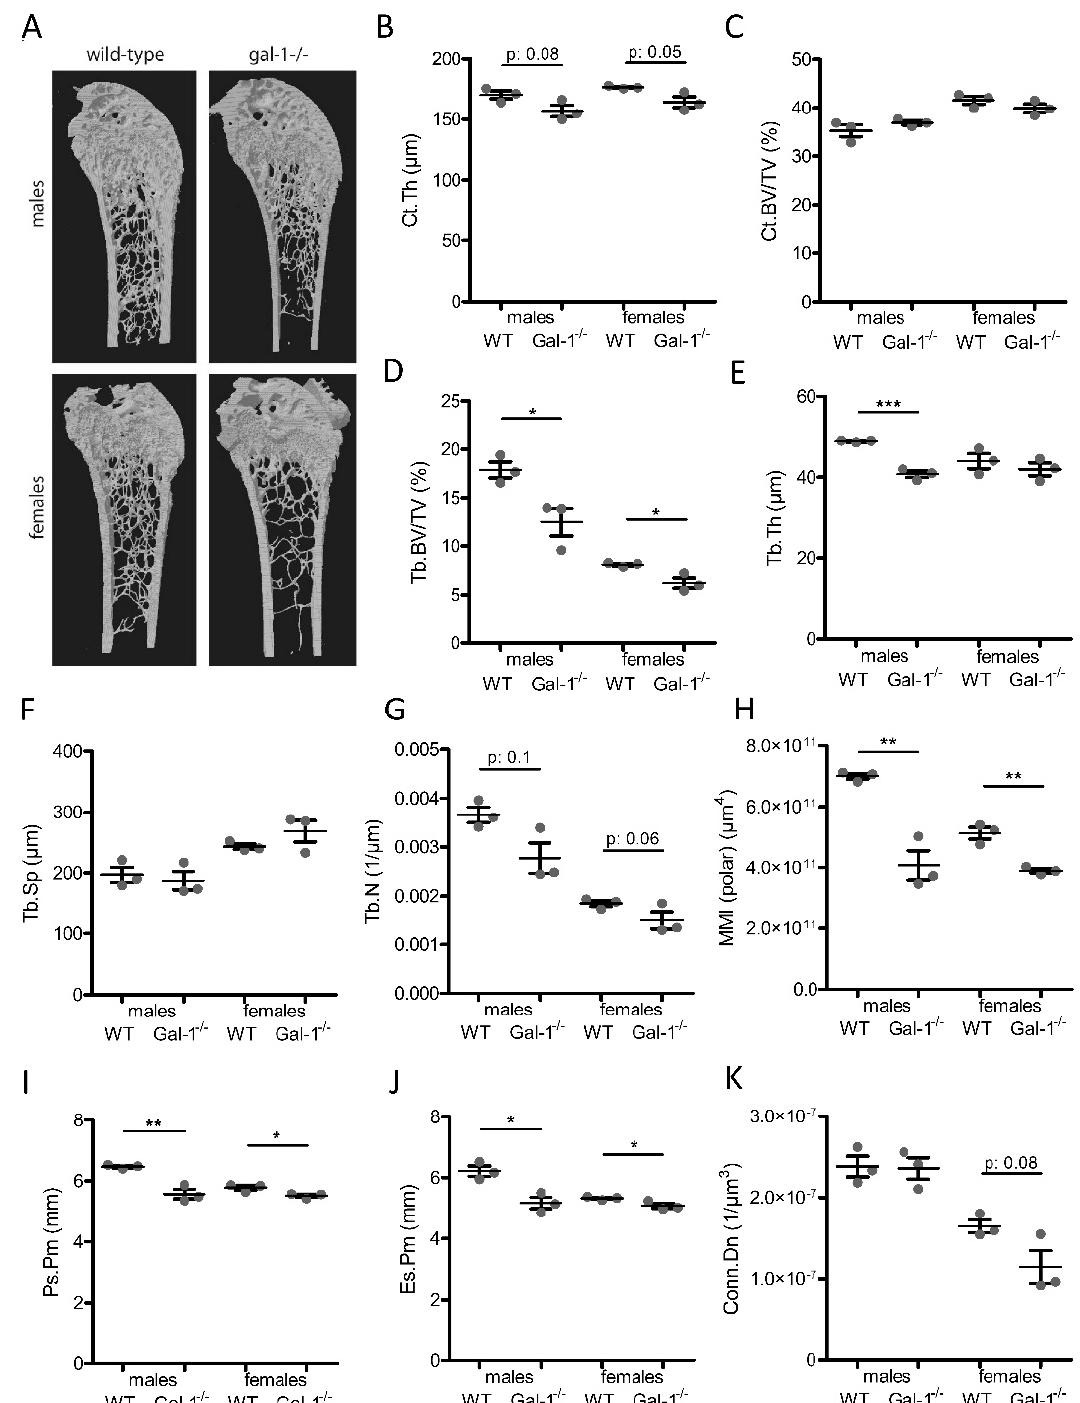
Figure 3. C57BL/6 gal-1 − / − have a decreased bone mass. ( A ) Representative 3D-reconstructions of distal femurs. CTAn analysis was performed and ( B ) cortical thickness (Ct;Th), ( C ) cortical bone volume (Ct.BV/TV), ( D ) trabecular bone volume (Tb.BV/TV), ( E ) trabecular thickness (Tb.Th), ( F ) trabecular separation (Tb.Sp), ( G ) trabecular number (Tb.N), ( H ) polar mean moment of inertia (MMI(polar)), ( I ) periosteal perimeter, ( J ) endosteal perimeter and ( K ) trabecular connective density (Conn.Dn) are reported here. Data shown are the mean +/ − standard error of three mice and all results shown are representative of three biologically independent experiments. * p < 0.05; ** p < 0.01; *** p < 0.001.